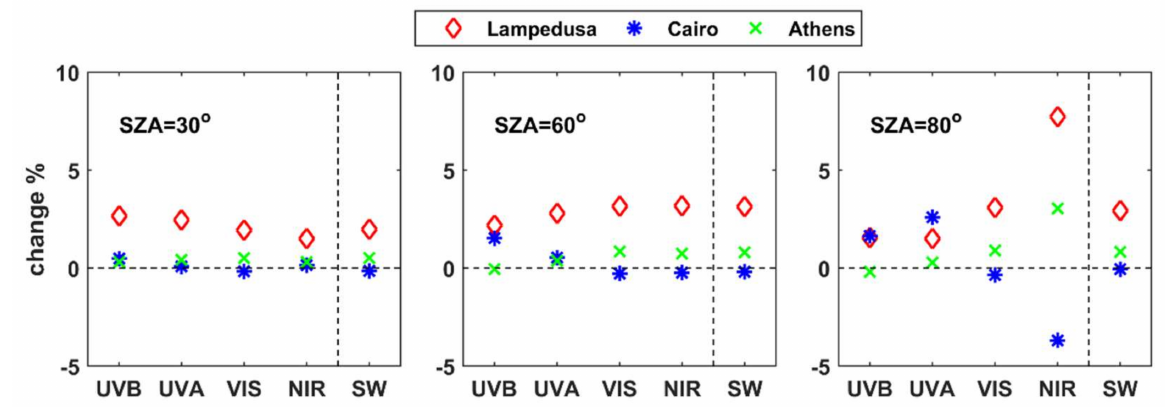
Figure 16. Changes (in %) in the simulated GI at BOA due to the use of the LIVAS profiles instead of the default